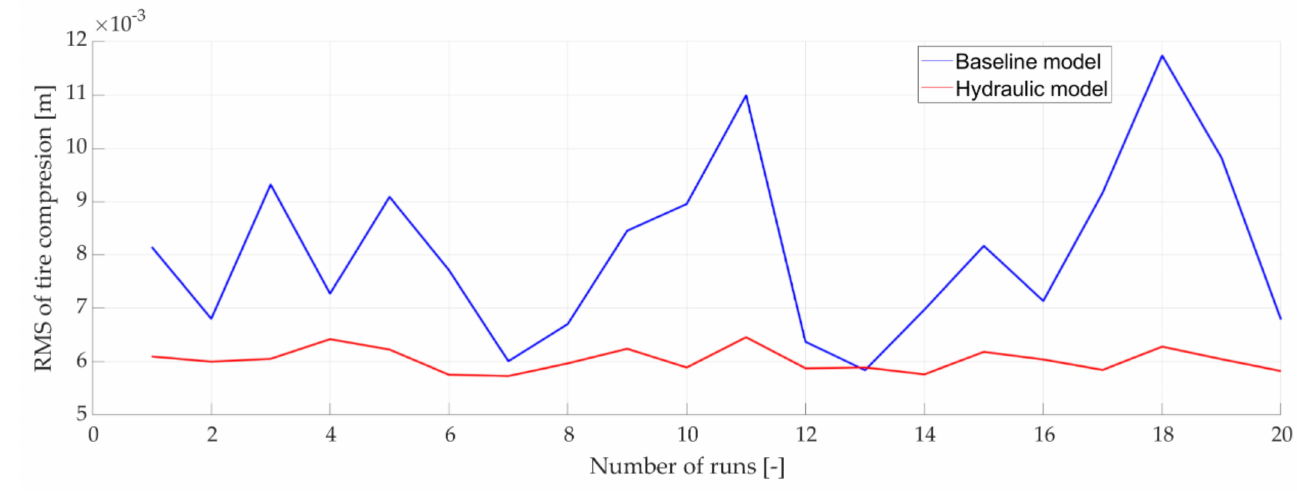
Figure 26. The root means square of the front left wheel vertical motion relative to the road.